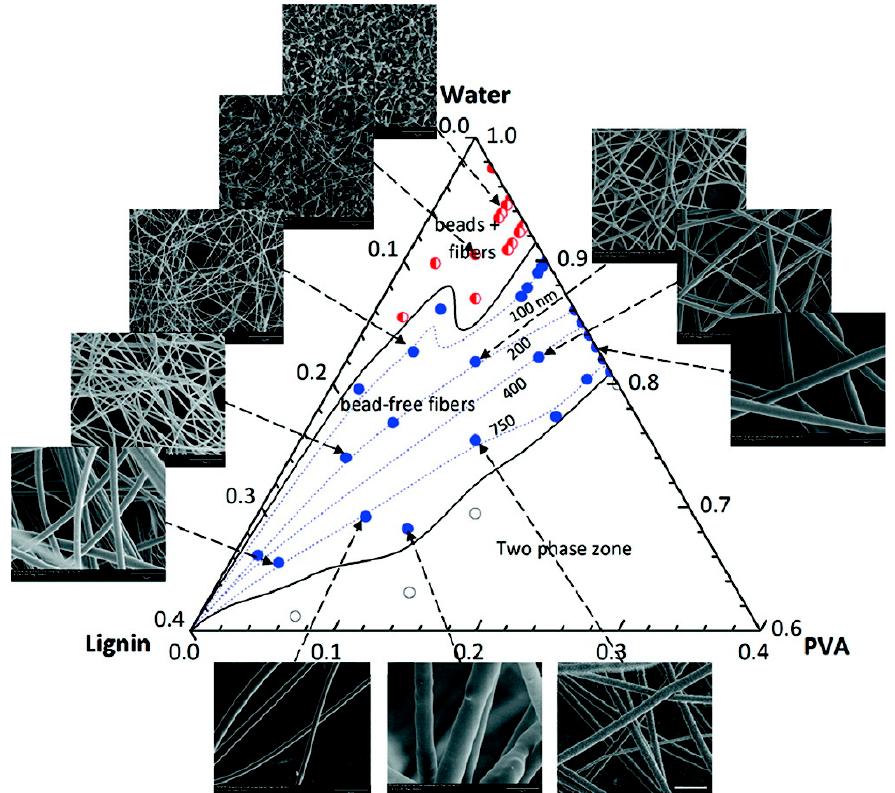
Figure 15. Ternery diagram showing the respective fiber morphology of the initial spinning solution composition where red circles indicate beading, blue circles indicate bead-free fibers, and unfilled white circles indicate a phase separation zone (not suitable for electrospinning). Representative SEM images are added around the ternary diagram and they include size bars of 5 µm. Reprinted with permission from Ago et al. [129]. Copyright 2012 American Chemical Society.